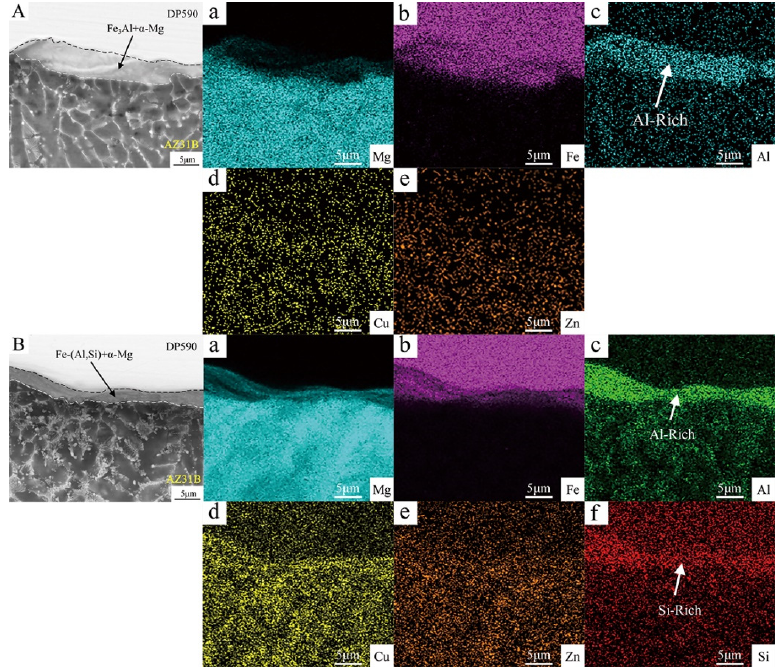
Figure 9. EDS map analysis at the magnesium alloy/steel interface in Figure 6: ( A ) Cu − 0%Si and ( B ) Cu − 5%Si.